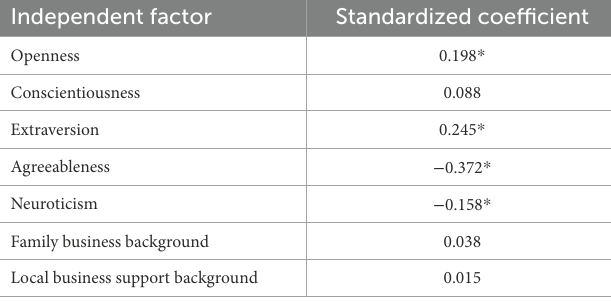
TABLE 3 The model of the big five factors of personality, sociological entrepreneurial background, and establishment of companies (structural equation